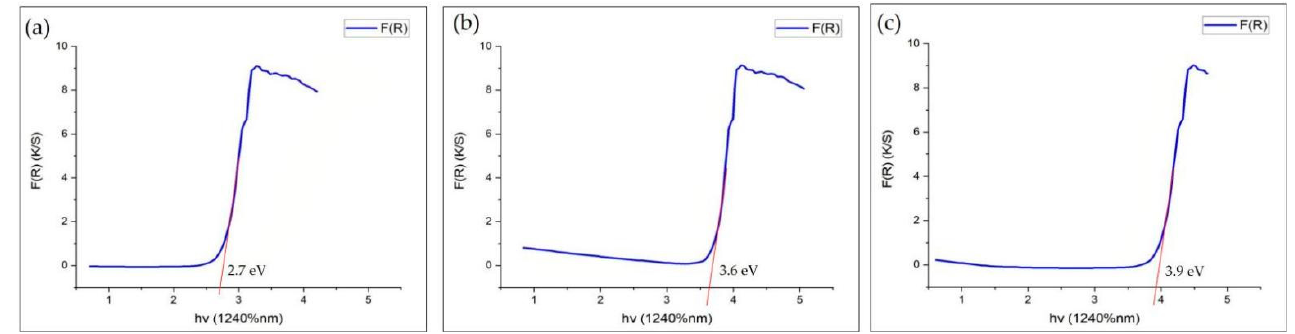
Figure 9. DRS images of different sizes of TiO 2 NPs attained from ( a ) Bacillus subtilis [79], ( b ) Cassia fistula , and ( c ) hydrothermal heating [80]. fistula , and ( c ) hydrothermal heating